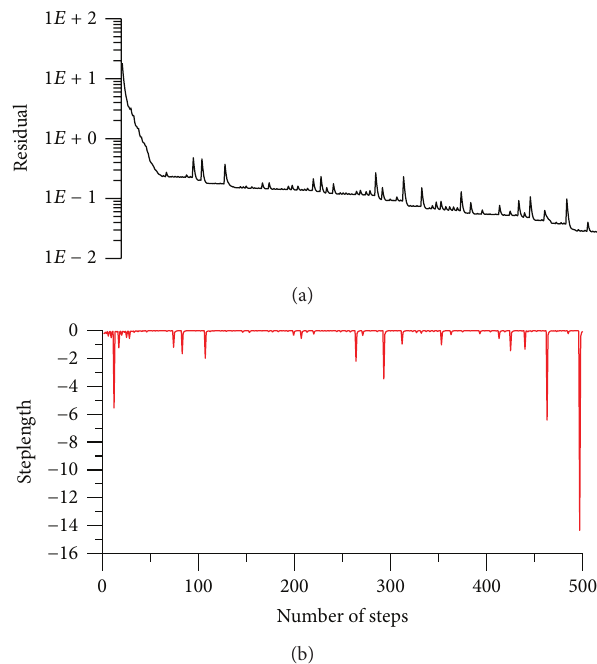
Figure 2: For Example 1, using (67) the algorithm does not converge and gives a negative